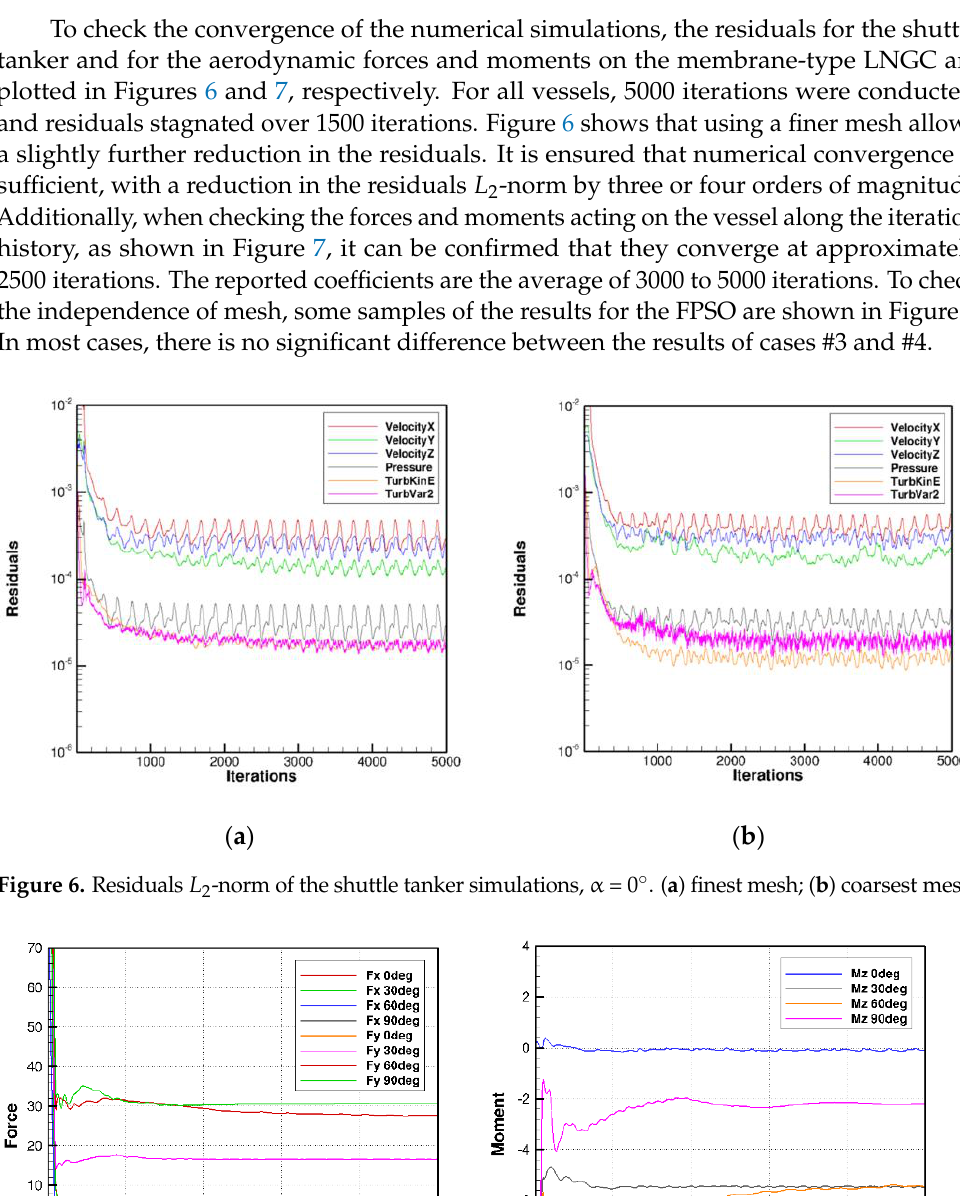
Figure 5. Computational grid system for wind load on offshore vessels. ( a ) FPSO; ( b ) Shuttle tanker; ( c ) Membrane-type LNGC; ( d ) Moss-type LNGC. Table 2. Computational meshes used for CFD calculations.